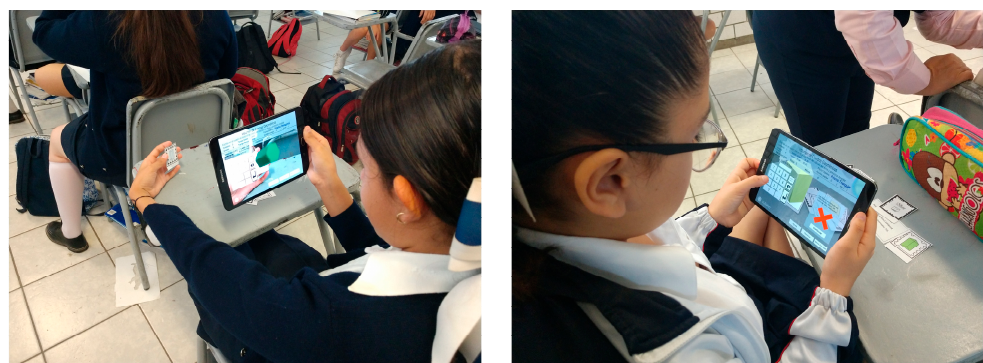
Figure 4. Students solving volume of regular prism exercises.